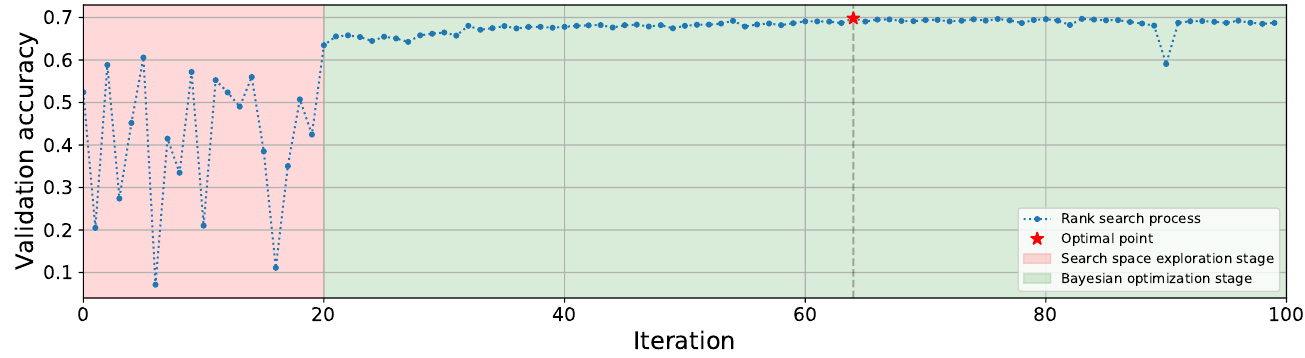
Figure 7. Visualization of the convergence of the calibrated accuracy in our rank search procedure for the 3.5 FLOP compression ratio of ResNet-18